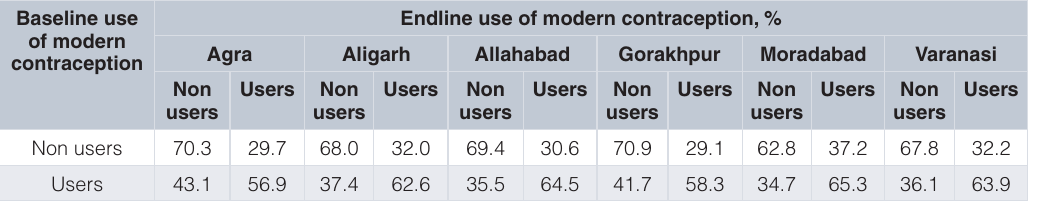
Table 4. City-specific change in use of modern contraception between baseline to endline.